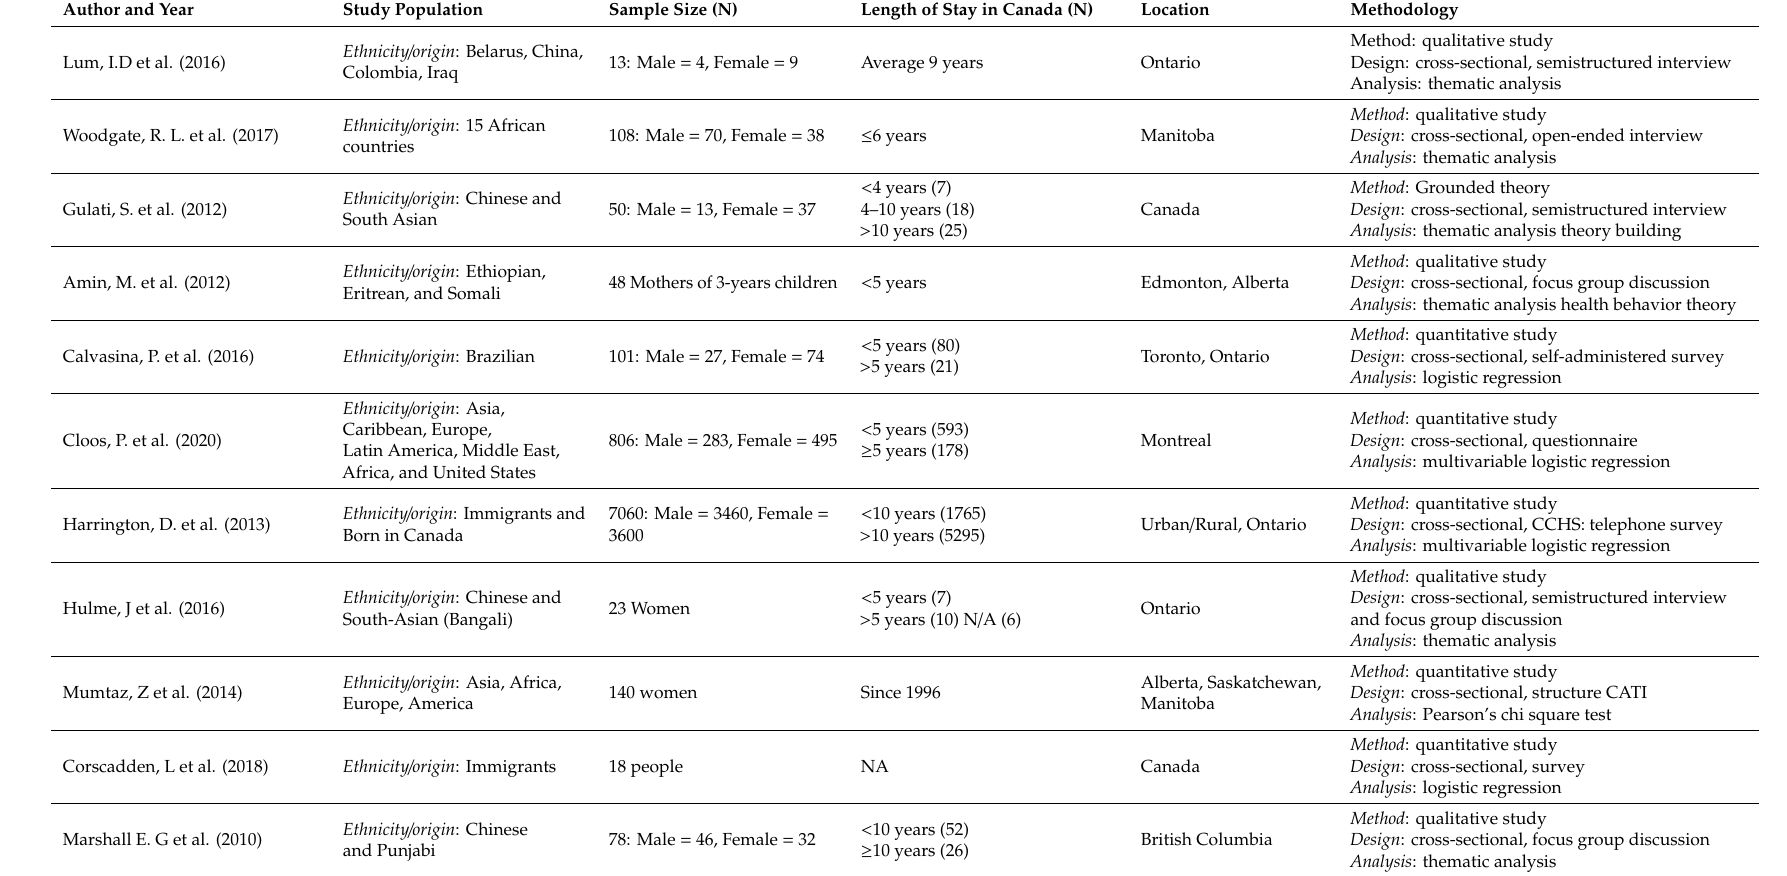
Table 1. Characteristics of the studies included in the